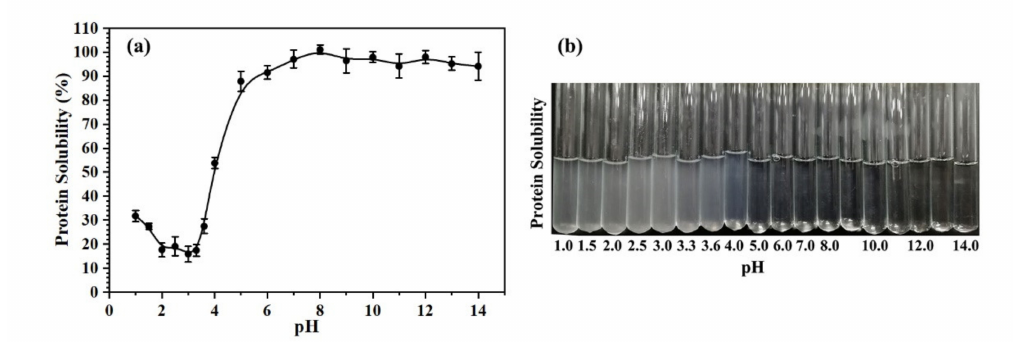
Figure 1. The solubility of Oviductus Ranae protein in different pH environments. ( a ) The solubility curve of Oviductus Ranae protein, ( b ) the solution phenomenon of Oviductus Ranae protein in different pH